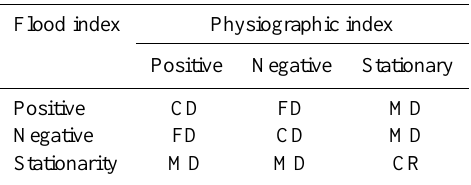
Table 3. Three-by-three contingency table of trends for flood and physiographic indices. Each cell contains the number of catchments respecting the trends in the row (for flood indices) and column (for physiographic indices).